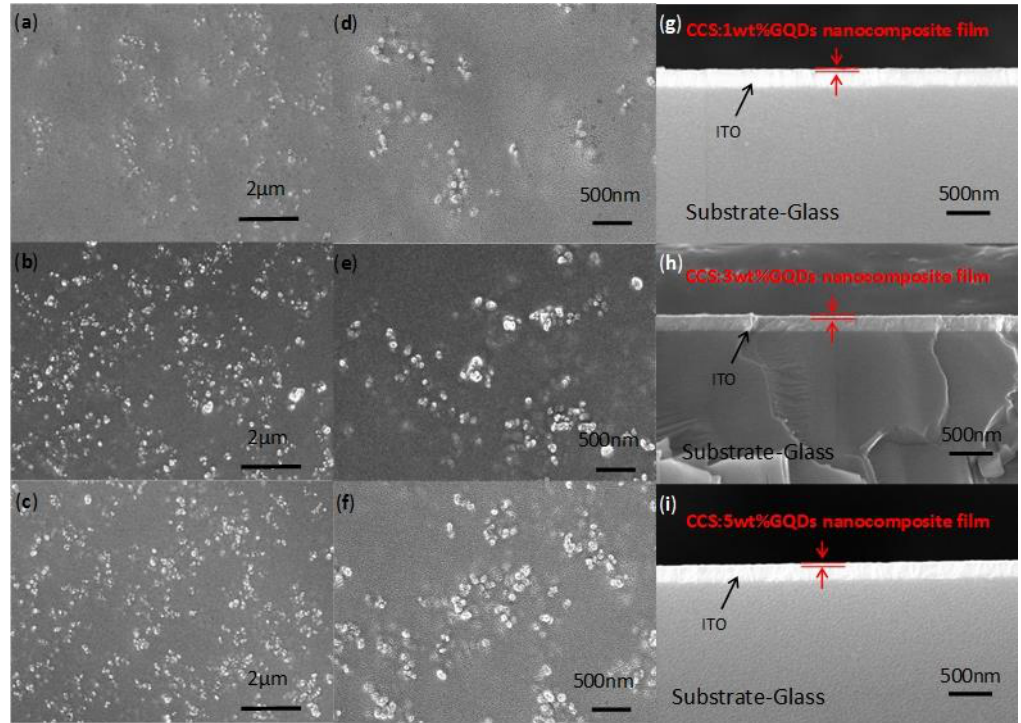
Figure 4. Morphological characterization of CCS: 1 wt% GQDs, CCS: 3 wt% GQDs and CCS: 5 wt%